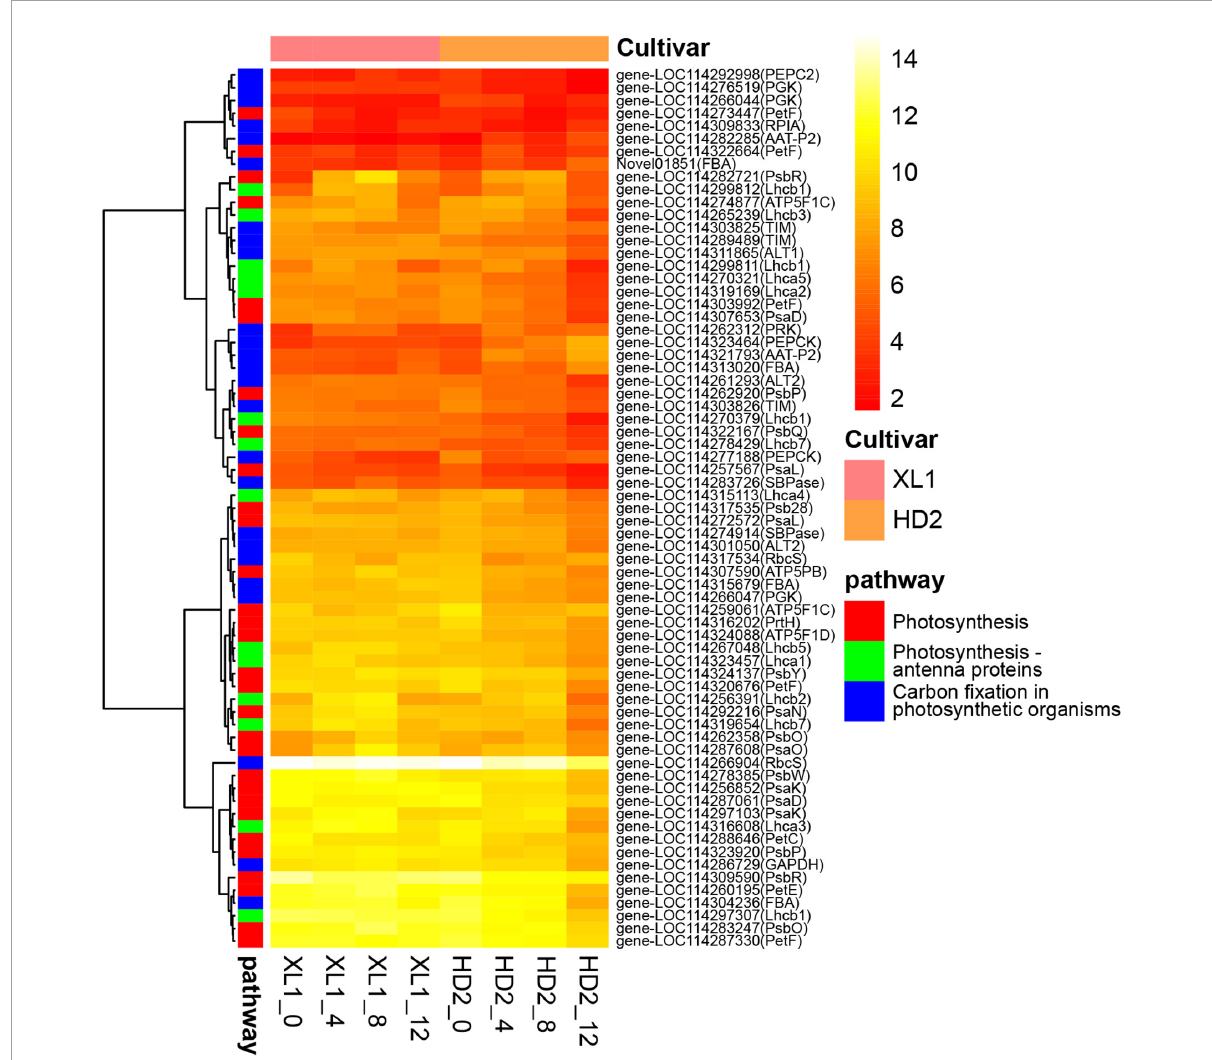
FIGURE5 The heatmap of DEG involve in photosynthesis-related pathways. The heatmap was generated from the log 2 (FPKM + 1) of three replicates for each sample, and the values of clustering distance were “correlation” and the clustering algorithms was “complete.”